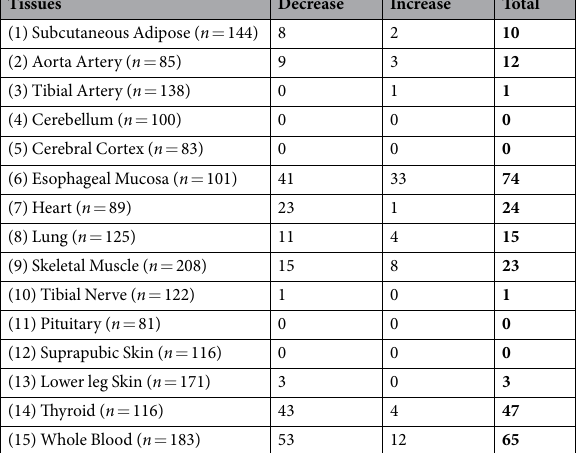
Table 3. Numbers of PMI-associated differentially variable (DV) genes across 15 different human